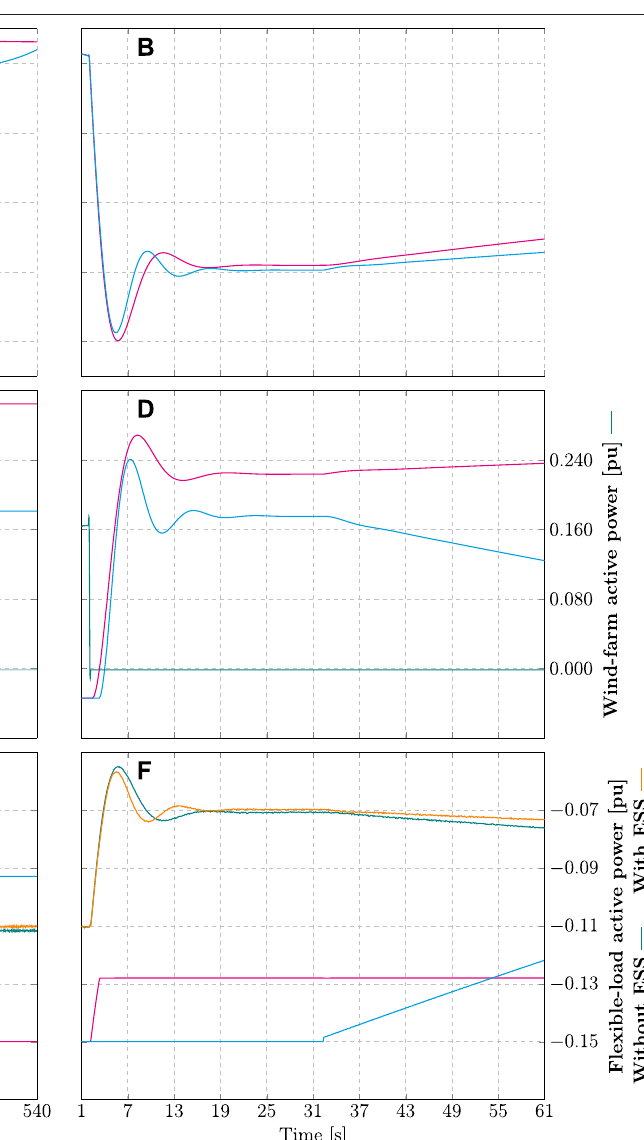
FIGURE10| Casestudybehaviorduringthewindfarmdisconnectionunderfullproduction(12MW)withandwithouttheproposedESS:normalizedangularspeed (A) during the whole transient and (B) detail of the fi rst minute; turbo-generator and wind farm active power in pu (C) during the whole transient and (D) detail of the fi rst minute; active power of the ES devices responsible for primary control (ES1) and secondary control (ES2) (E) during the whole transient and (F) detail of the fi rst minute.